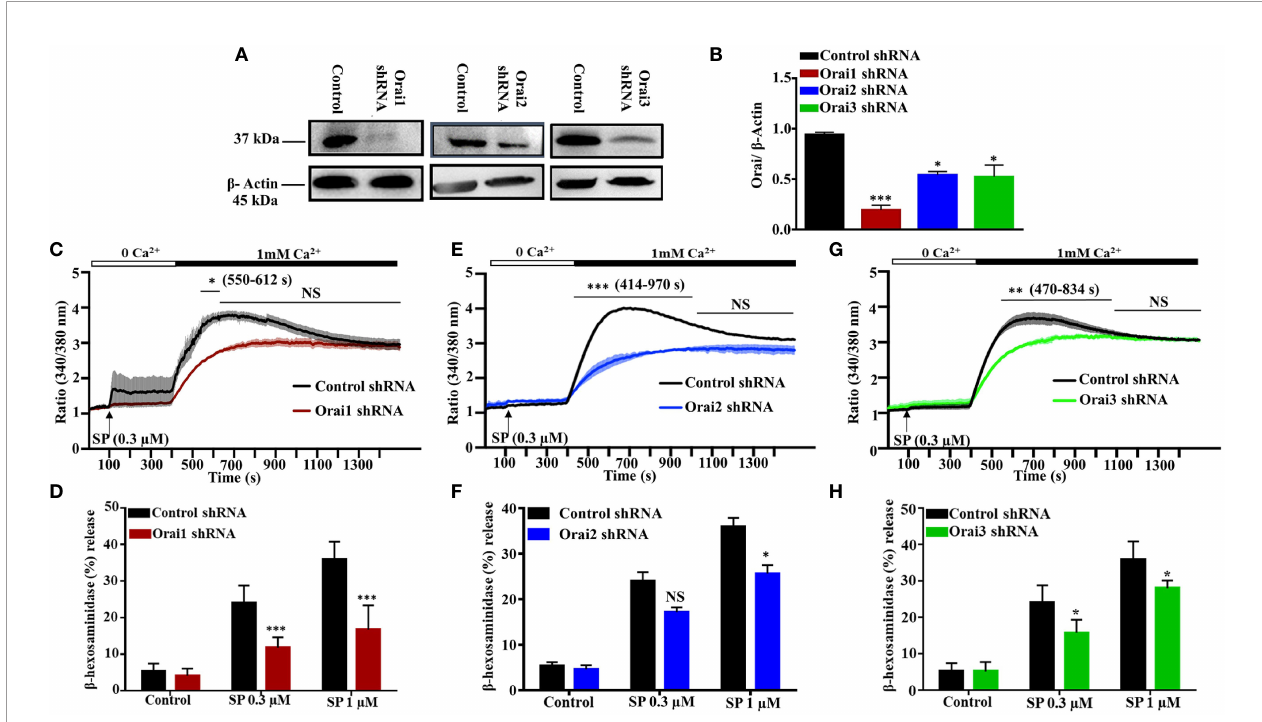
FIGURE 1 | Lentiviral shRNA-Mediated Knockdown of Orai1, Orai2, and Orai3 Reduces SP-Induced Responses in LAD2 Cells. (A) Knockdown ef fi ciency of each Orai channel was determined by western blotting in cells transduced with non-targeted (control) or Orai-speci fi c shRNA and a representative blot is shown. (B) Quanti fi cation of Orai knockdown is represented as bar graph of relative intensities of Orai protein bands normalized to respective b -Actin. (C, E, G) Cells were loaded with Fura-2AM, resuspended in Ca 2+ -free buffer (1.5 ml) and measurement of intracellular Ca 2+ mobilization was initiated via the addition of SP (0.3 µM, at 100s). At 400 s, Ca 2+ concentration of the buffer was increased to 1 mM via the addition of 1.5 µl of 1 M calcium and in fl ux was measured for additional 18 min. (D, F, H) Effects of Orai knockdown on SP- induced degranulation, as measured by b -hexosaminidase release. Data presented are mean ± SEM of N = 4 experiments. Statistical signi fi cance was determined by two-way ANOVA with Tukey ’ s multiple comparisons at a value ***p < 0.001, **p < 0.01, *p < 0.05, and NS, “ not signi fi cant ”